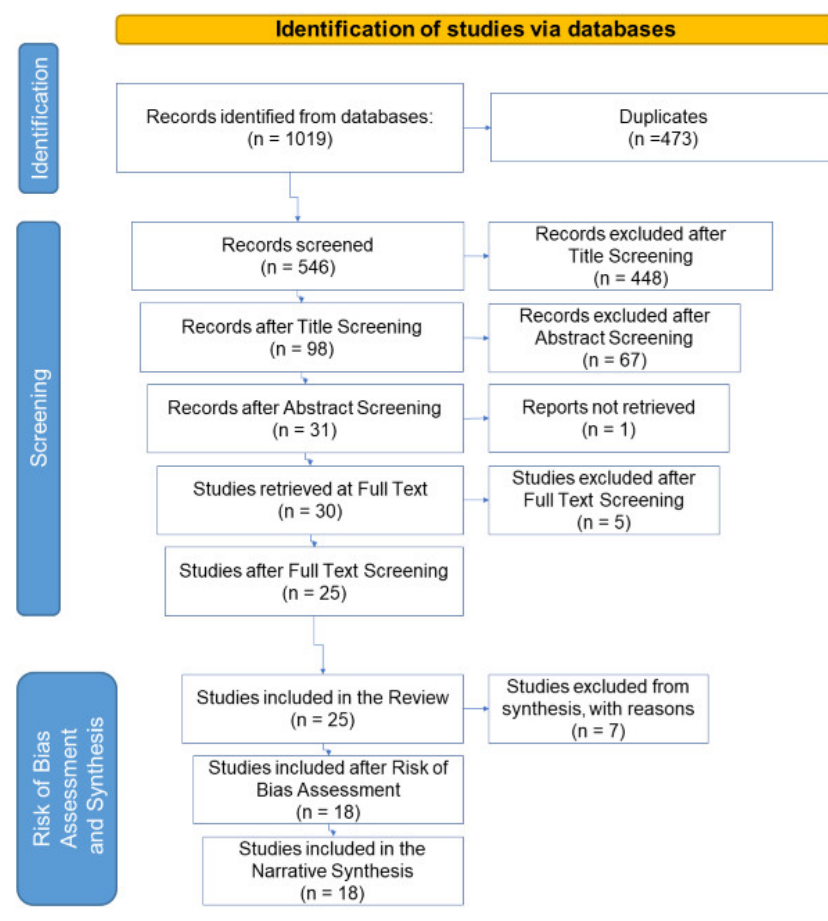
Figure 1. PRISMA flowchart representing the number of the rejected studies at each stage.